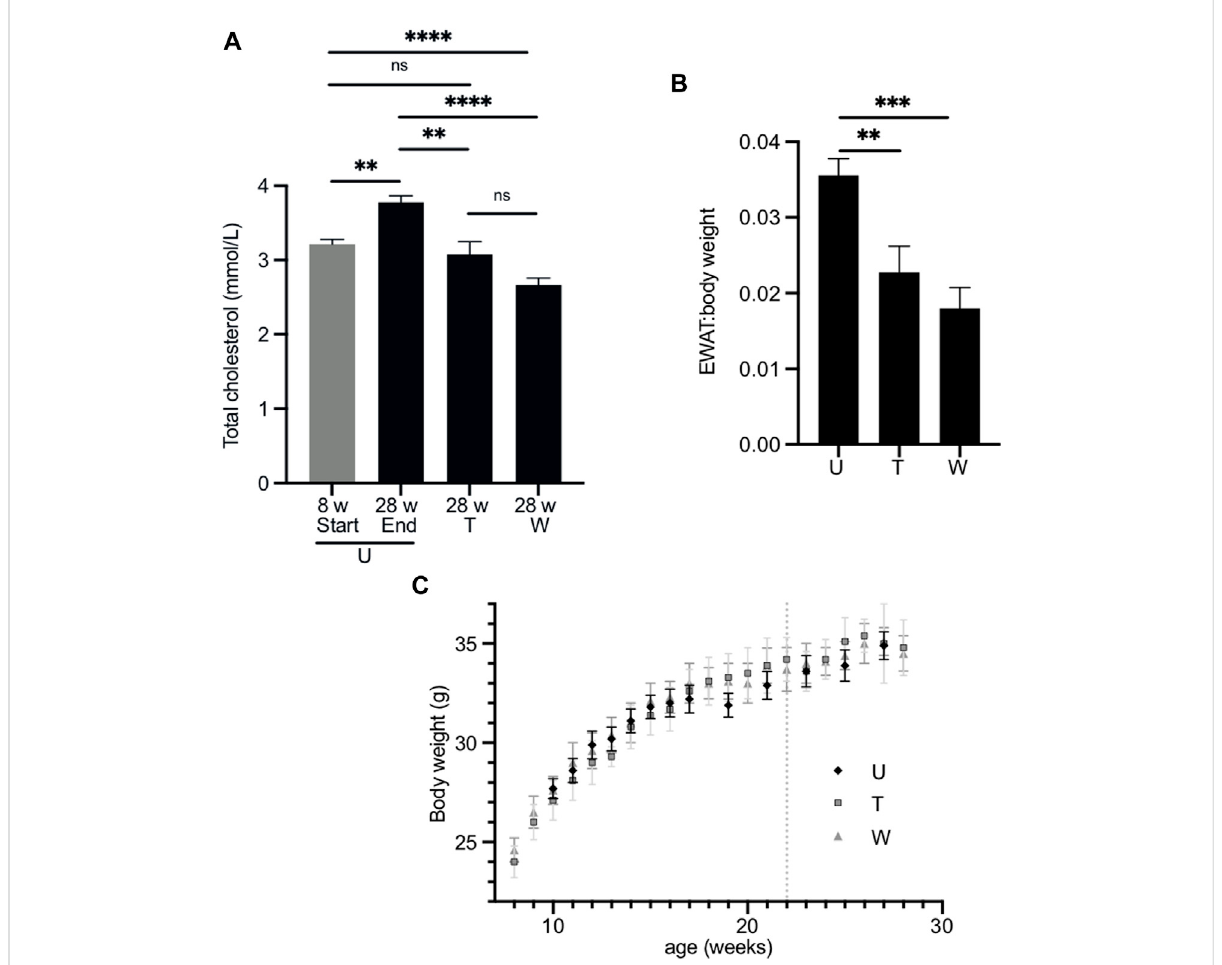
FIGURE 4 Effect of long-term treatment with 2,3-butanediol on plasma cholesterol, EWAT:body weight ratio and body weight. (A) . Male mice were untreated (U) and aged 8 ( n = 8) or 28 weeks of age ( n = 23). The “ washout ” cohort (W) ( n = 4) were treated with 2,3-butanediol for 14 weeks (from 8 to 22 weeks of age) and then maintained on water to 28 weeks of age. The “ throughout ” cohort (T) ( n = 4) were treated with 2,3-butanediol from 8to28 weeksofage. (B) EWAT:bodyweightratioofU,WorTmiceat28weeksofage. (C) BodyweightovertimeofU,W,andTcohorts.Dotted line indicates withdrawal of 2,3-butanediol from the washout cohort. Data are expressed as means ± SEM. ** p < 0.01, *** p < 0.001, **** p <